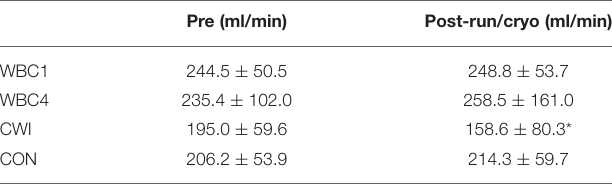
TABLE 2 | Femoral artery blood flows for WBC1, WBC4, CWI, and CON groups.